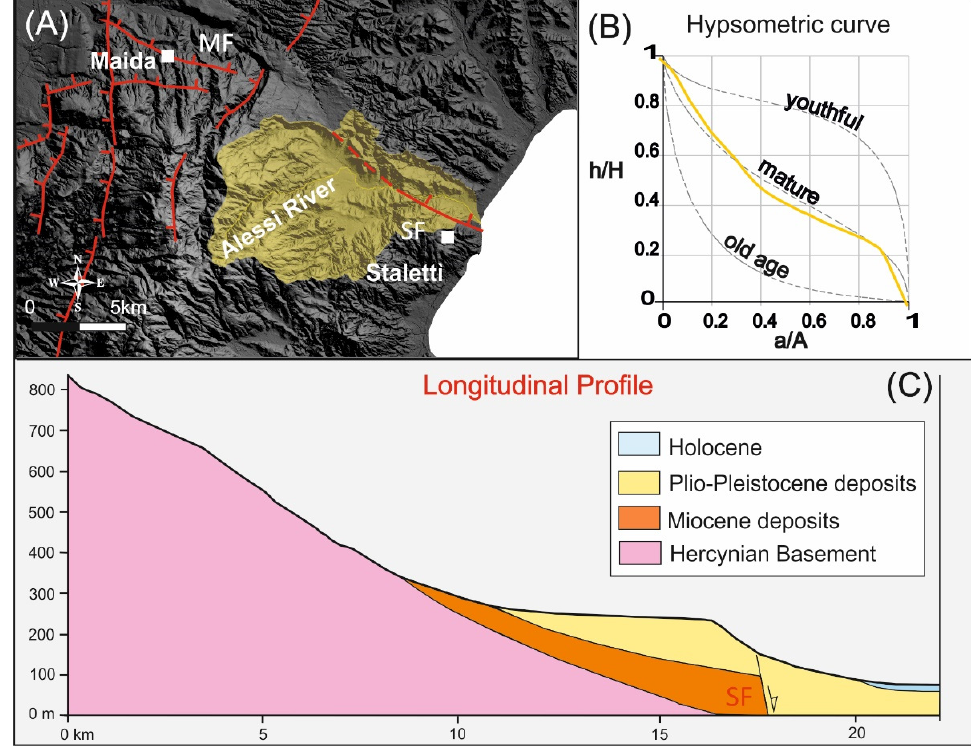
Figure 10. ( A ) DTM hillshade showing the Alessi sub-basin and faults crossing the area. ( B ) Hypsometric curve of the Alessi sub-basin. ( C ) Longitudinal profile of the main river trunk of the Alessi sub-basin.